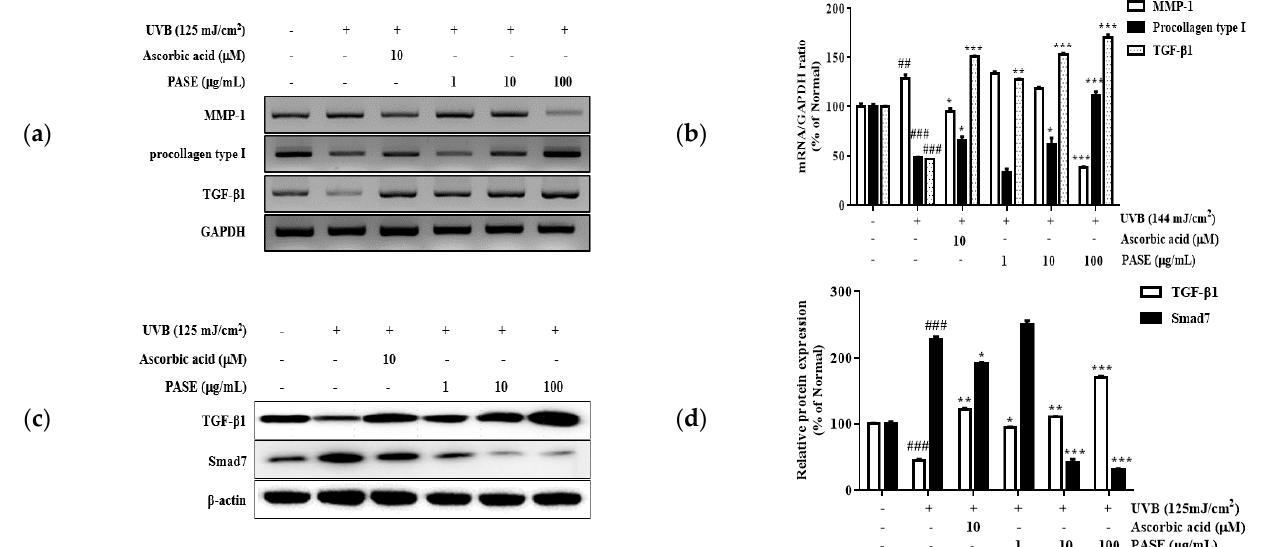
Figure 5. PASE inhibited MMP-1, procollagen type I, and TGF- β 1 mRNA expression and TGF- β 1 and Smad7 protein levels in UVB-exposed HaCaT cells: MMP-1, procollagen type I, and TGF- β mRNA levels ( a ); TGF- β 1/Smad7 protein expression ( c ); the band intensities ( b , d ). Data are presented as means ± SDs of three independent experiments. ## p < 0.01, ### p < 0.001 compared with non-exposed group, * p < 0.05, ** p < 0.01, *** p < 0.001 compared with only UVB-exposed group.